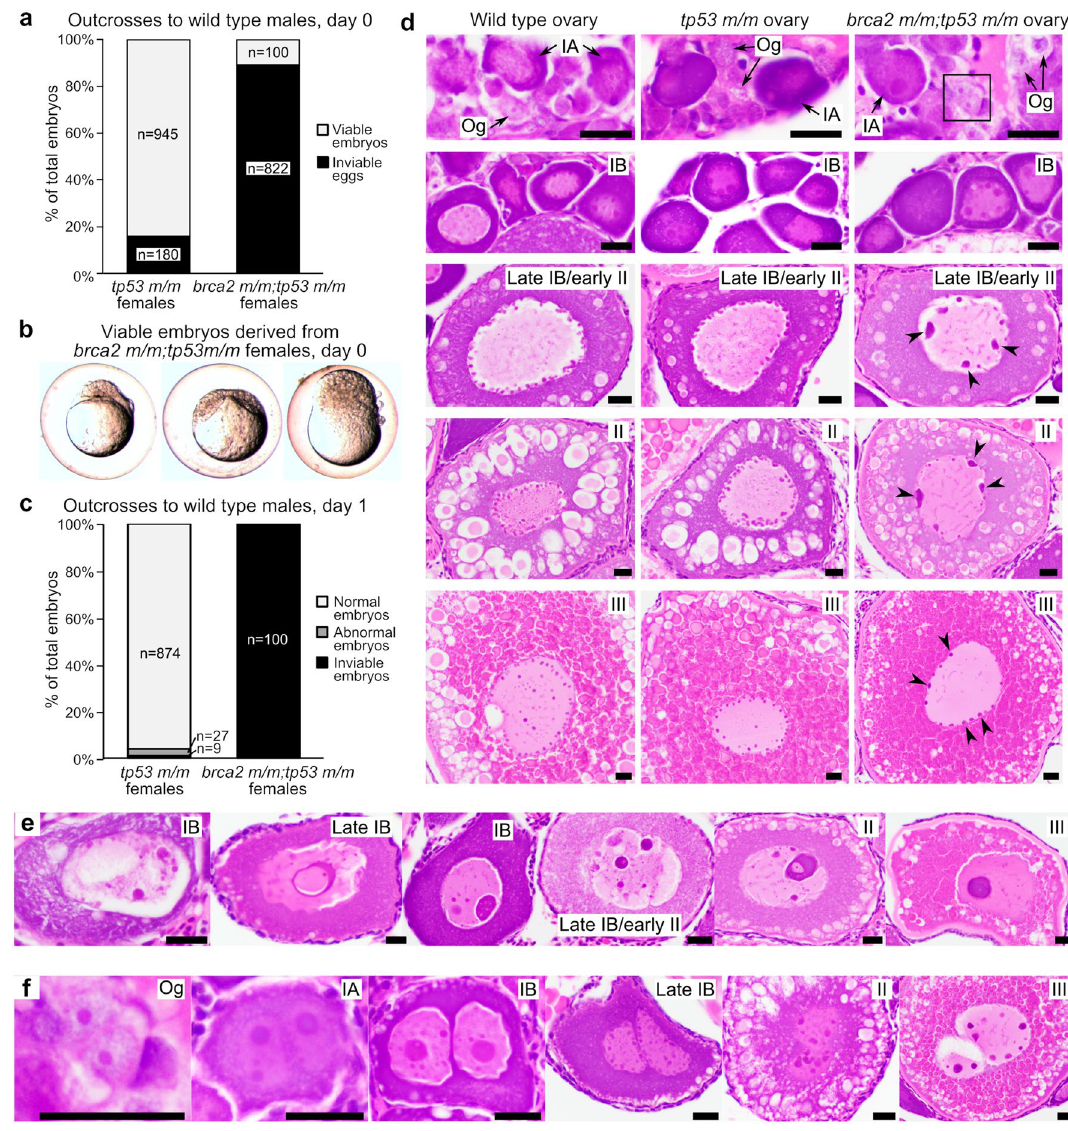
Figure 1. Embryos from brca2 m/m;tp53 m/m female zebrafish undergo proliferation arrest and death and oocytes exhibit abnormal nuclear morphology. ( a ) Most eggs derived from brca2 m/m;tp53 m/m females are inviable and only a small number of viable embryos are generated, in contrast to tp53 m/m females. Females were outcrossed to fertile wild type males. ( b ) On day 0, viable embryos derived from brca2 m/m;tp53 m/m embryos are often morphologically abnormal and all undergo developmental arrest at or before sphere stage (approximately four hours post-fertilization). ( c ) At one day post-fertilization (day 1), greater than 90% of embryos derived from tp53 m/m females are alive and morphologically normal, while all embryos derived from brca2 m/m;tp53 m/m females are dead. ( d ) Oocytes from brca2 m/m;tp53 m/m females exhibit nuclear abnormalities predominated by aggregated nucleolar material around nuclear margins (black arrowheads). Black box indicates oogonium shown at higher magnification in panel f. ( e ) Oocytes with massive nucleolar condensation are often degenerate. ( f ) Infrequent binucleation occurred in oogonia and oocytes from brca2 m/m;tp53 m/m females. Og, oogonia; IA, stage IA oocyte; IB, stage IB oocyte; II, stage II oocyte; III, stage III oocyte. Scale bar = 20